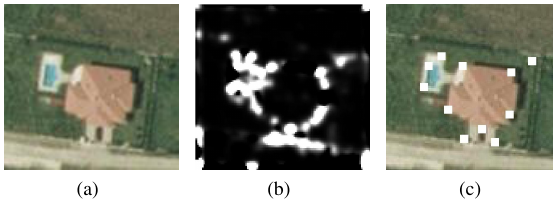
Figure 1: Operation of the Harris detector: (a) shows the original image; (b) is the R characteristic function; (c): Keypoints chosen as local maxima of R .